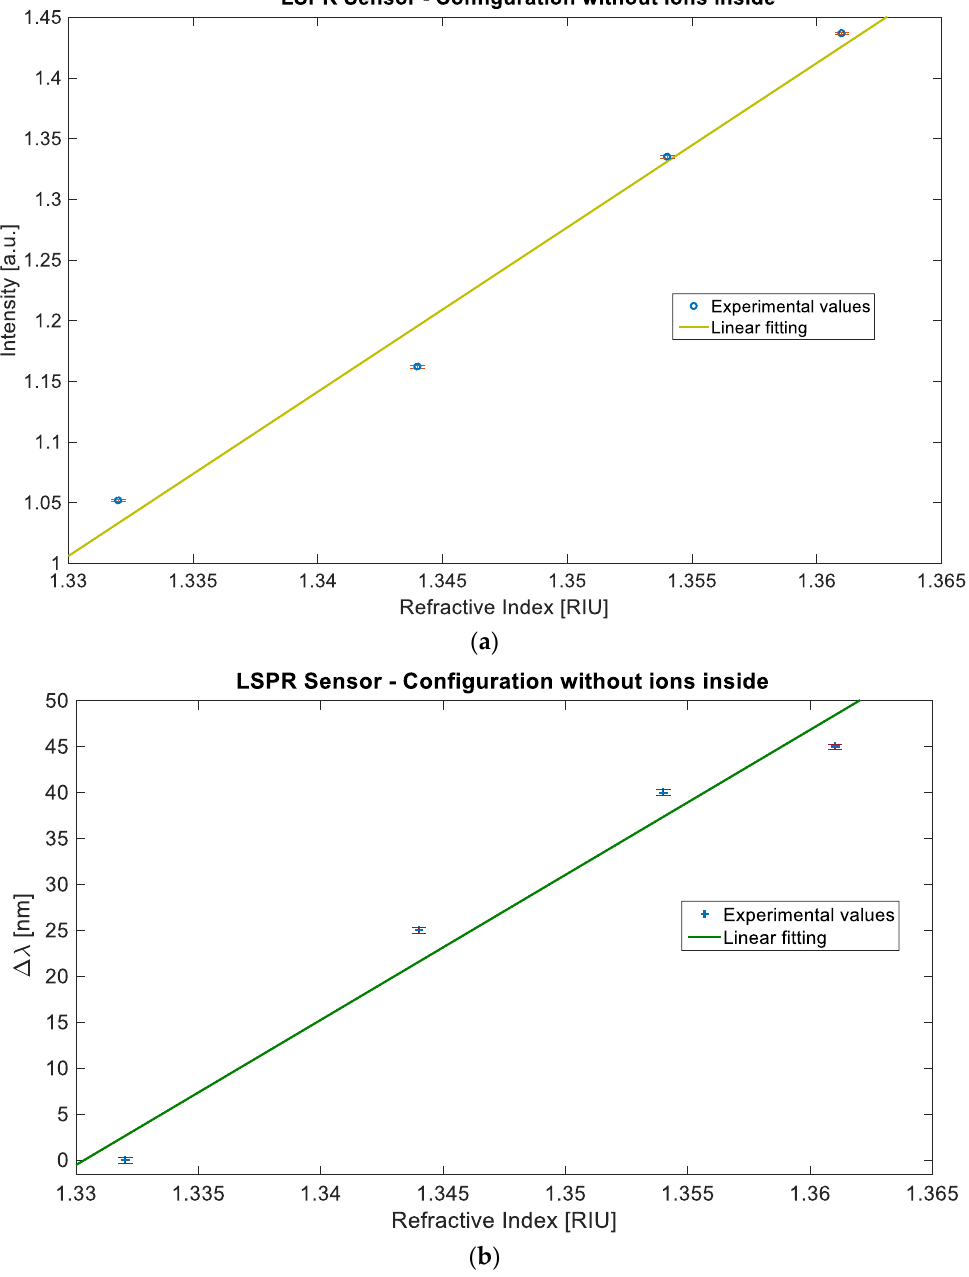
Figure 4. Experimental results of the sensor based on BC paper without ions: Measured values versus the refractive index, with the error bars and the linear fitting of the data. ( a ) Intensity value versus refractive index. ( b ) Resonance wavelength shift value versus refractive index.